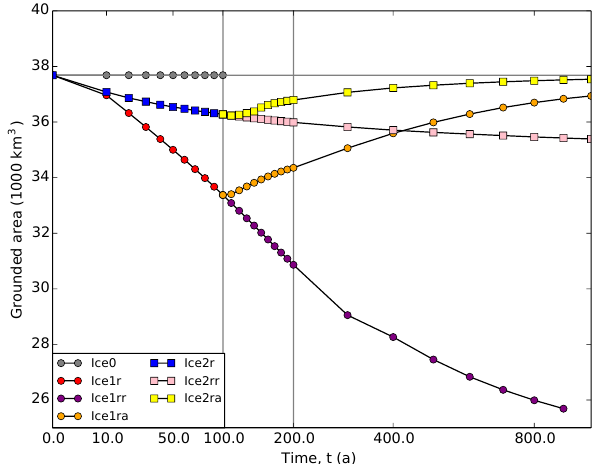
Figure 4. Grounded area plotted against time for the MISMIP + ex- periments, computed using BISICLES with the SSA and the Tsai et al. (2015) basal traction. The Ice0, Ice1r and Ice2r experiments all start from steady-state, and apply either zero melt (Ice0) or melt rates derived from simple formulae (Ice1r and Ice2r) from t = 0 to t = 100a. Following on from Ice1r, the Ice1ra and Ice1rr experi- ments evolve the ice sheet until at least t = 200a and optionally to t = 1000a, with the melt rate set to zero in Ice1ra and derived from the same formula as Ice1r in Ice1rr. Ice2ra and Ice2rr follow on from Ice2r in a similar fashion.